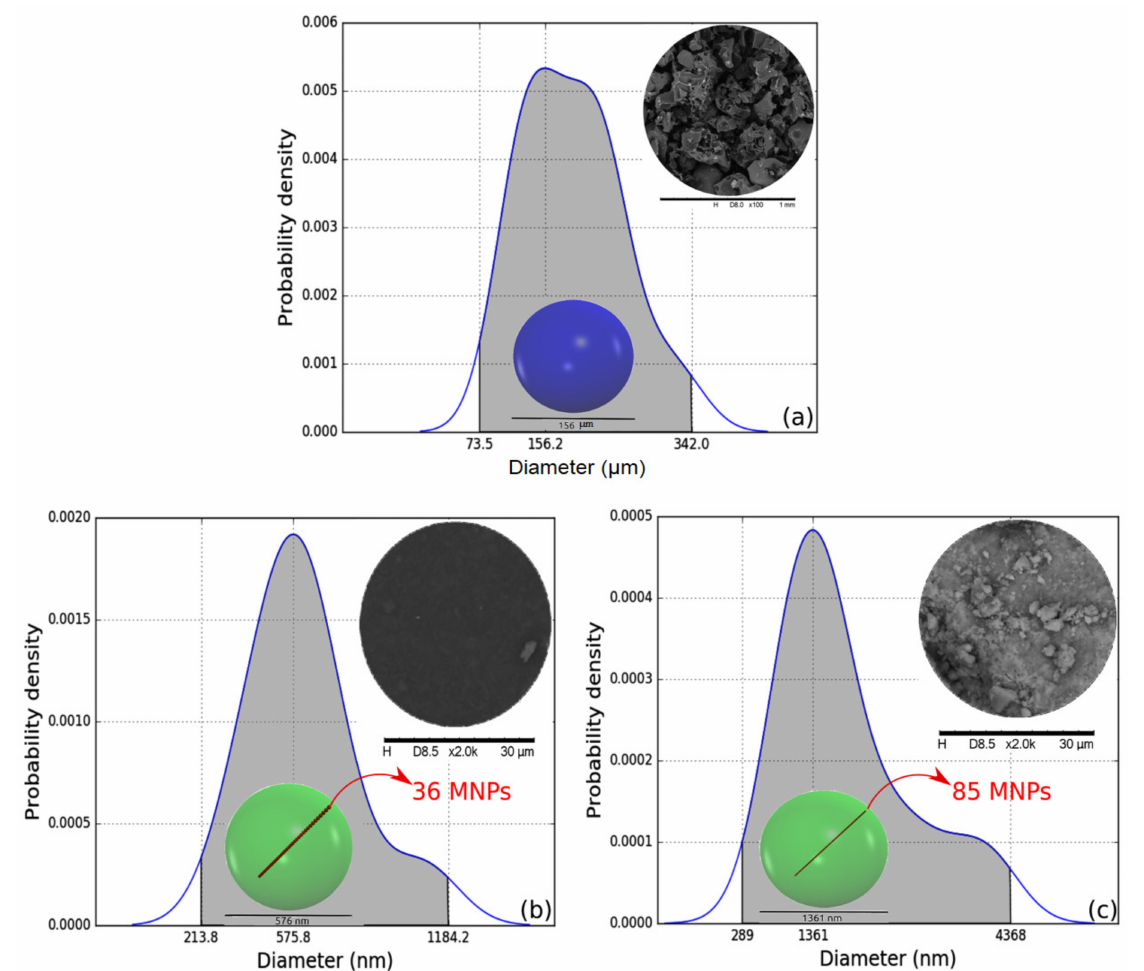
Figure 4. Grain size PDF functions of the resin ( a ), composite filled with three wt% of magnetite ( b ), and pure magnetite ( c ). Insets are the SEM of the samples (top right corners) and the representation of the most probable particle size (colored spheres inside the PDFs) of the polymer grains ( a ) and magnetite agglomerates ( b , c ). The small red spheres line inside the colored spheres ( b , c ) are the number of MNPs of diameter equal to 16 nm needed to fill the width of the larger